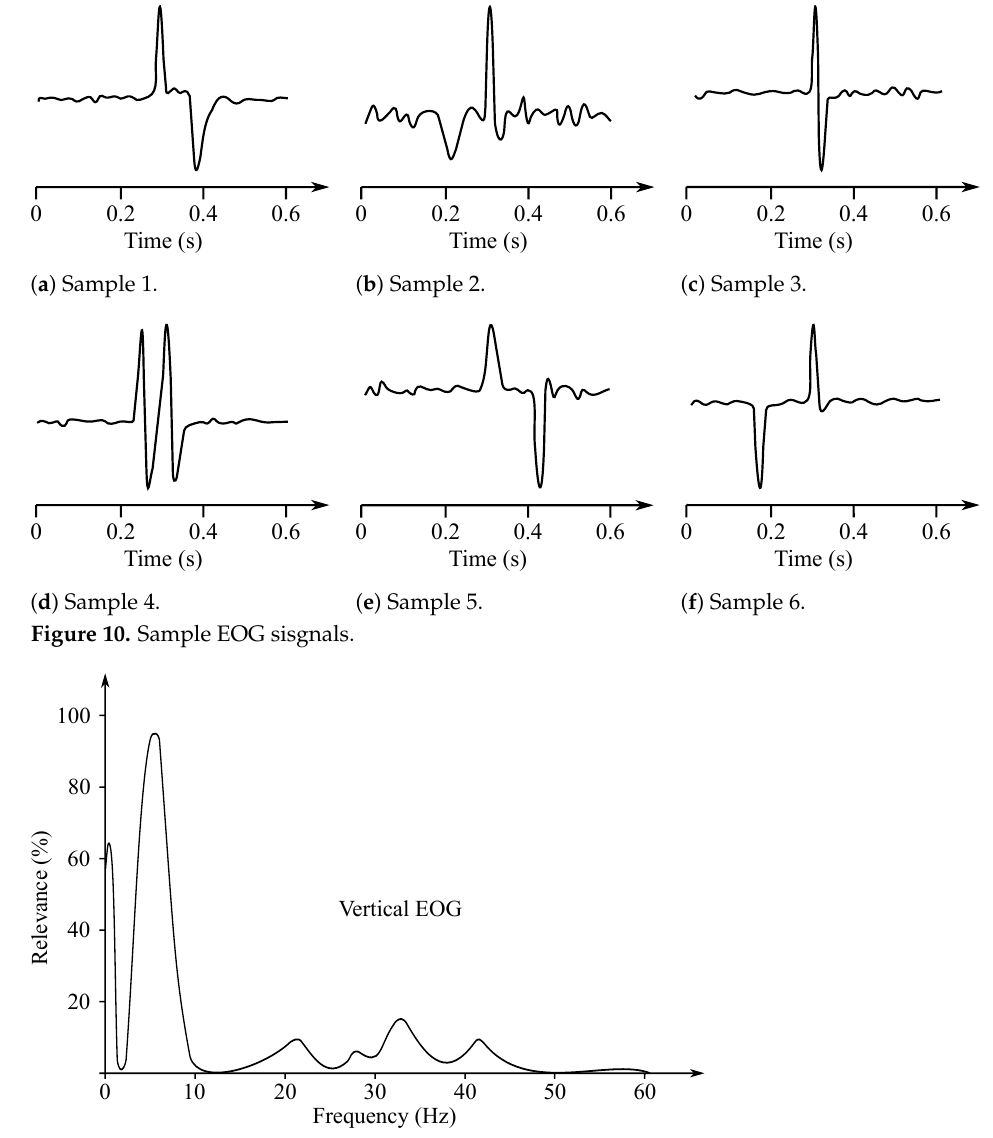
Figure 11. Sample EOG